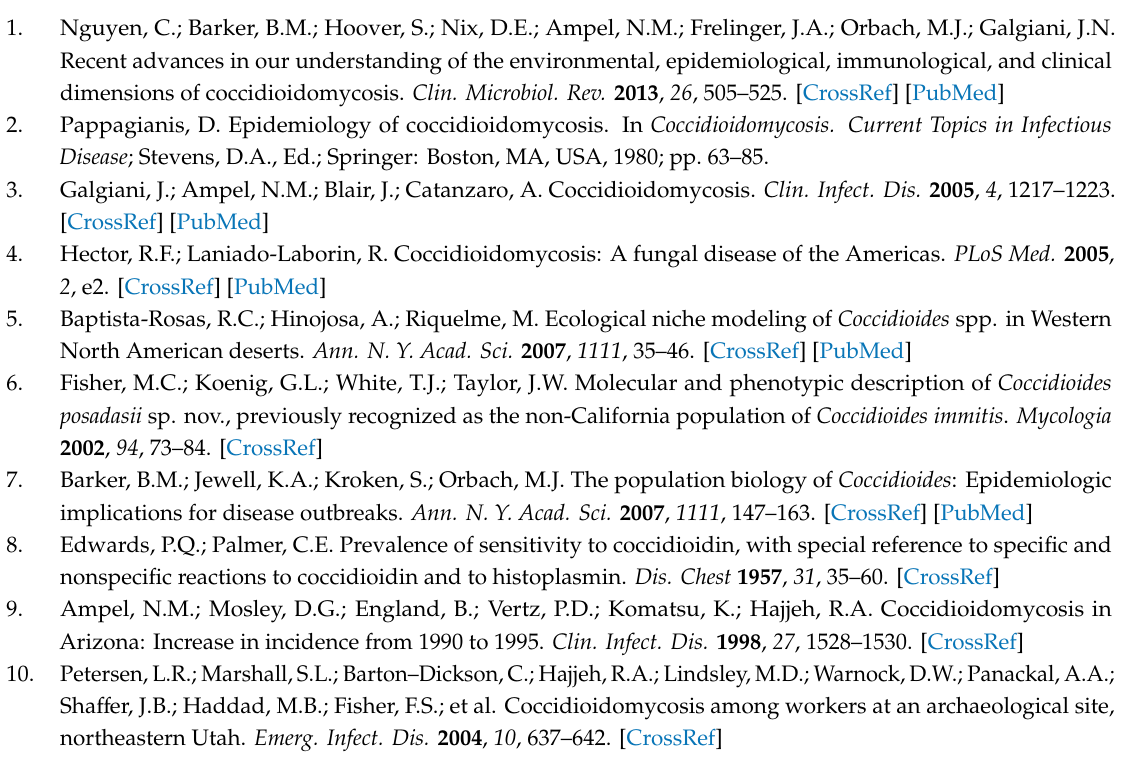
Figure S1. Phylogenetic trees for individual gene regions: Serine protease, MCM7, RPB1, and